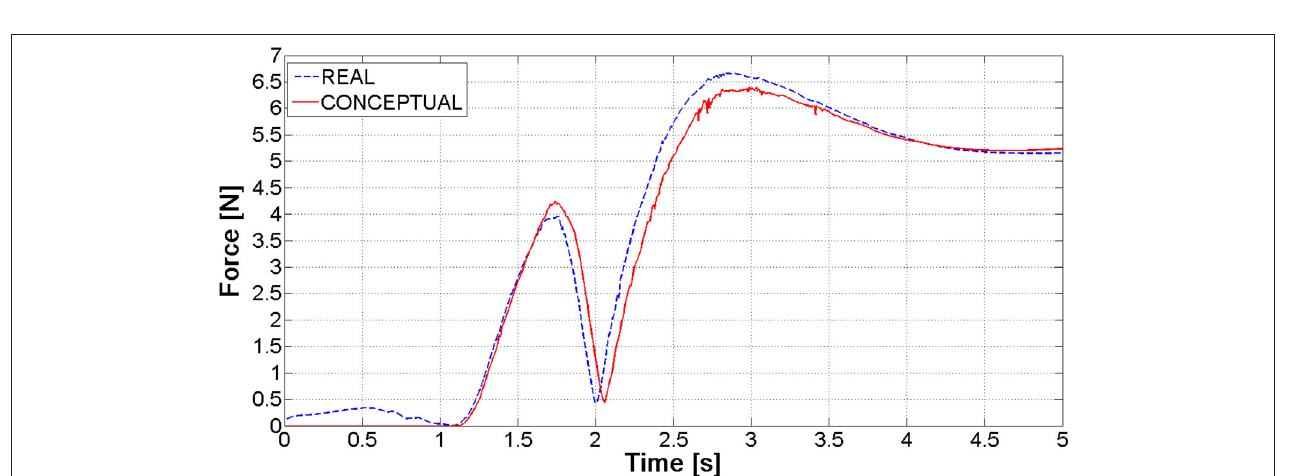
FIGURE 6 | Ring constraining force for the real and the conceptual ring.